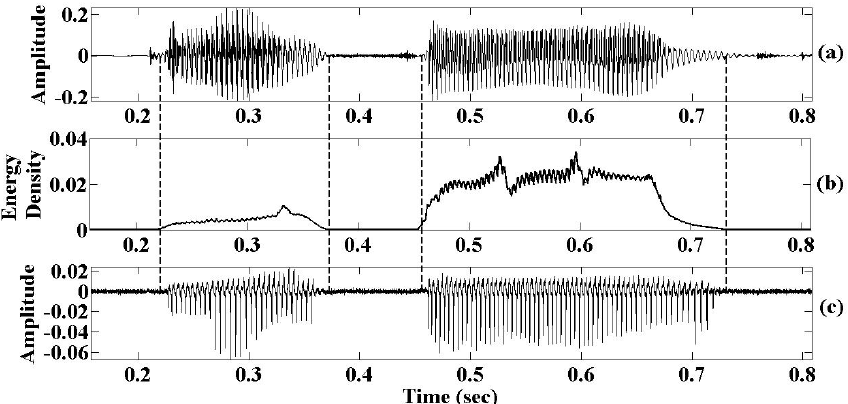
Figure 2. (a) Speech signal segment. (b) Marginal energy density of speech signal segment with respect to time for LFR. (c) DEGG signal. Reference voiced regions are shown by dashed lines. Speech signal is taken from the CMU-Arctic database with speaker id